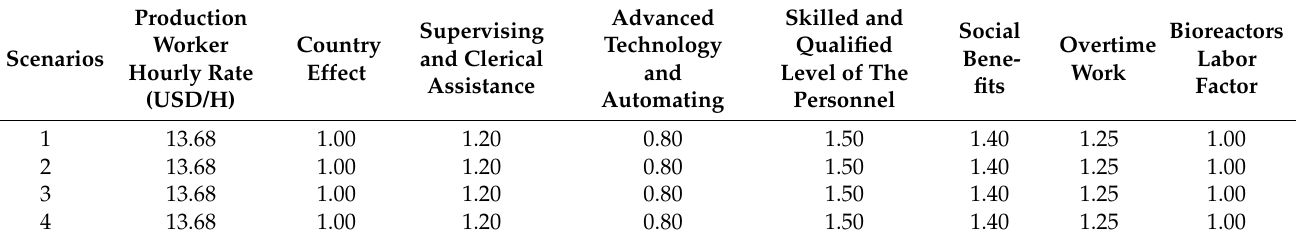
Table A6. Model variable inputs: Labor.